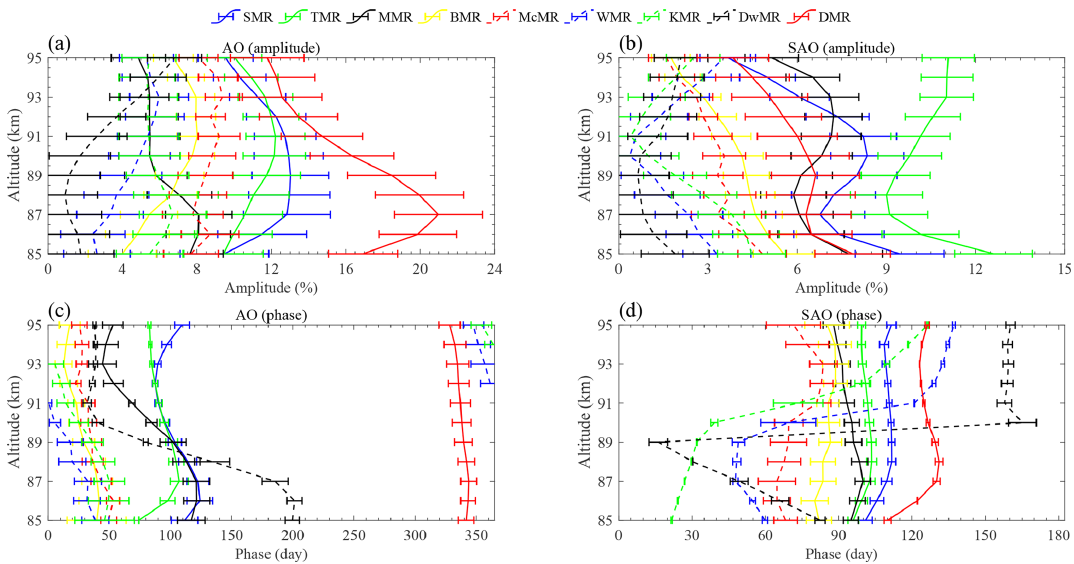
Figure 10. Amplitudes (a, b) and phases (c, d) of the AO and SAO observed by the nine meteor radars. The amplitude values indicate the percentage of the density relative to the mean density from the total observational time